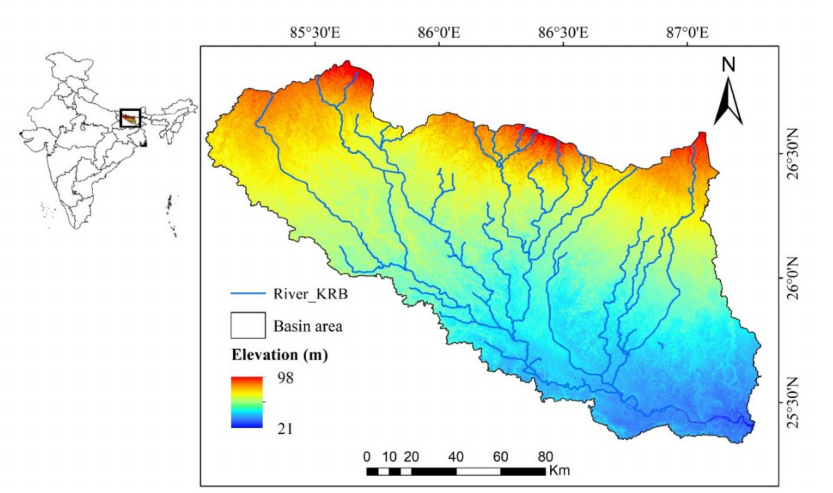
Figure 1. The geographical location of the KRB showing ground elevation (meter) using the SRTM